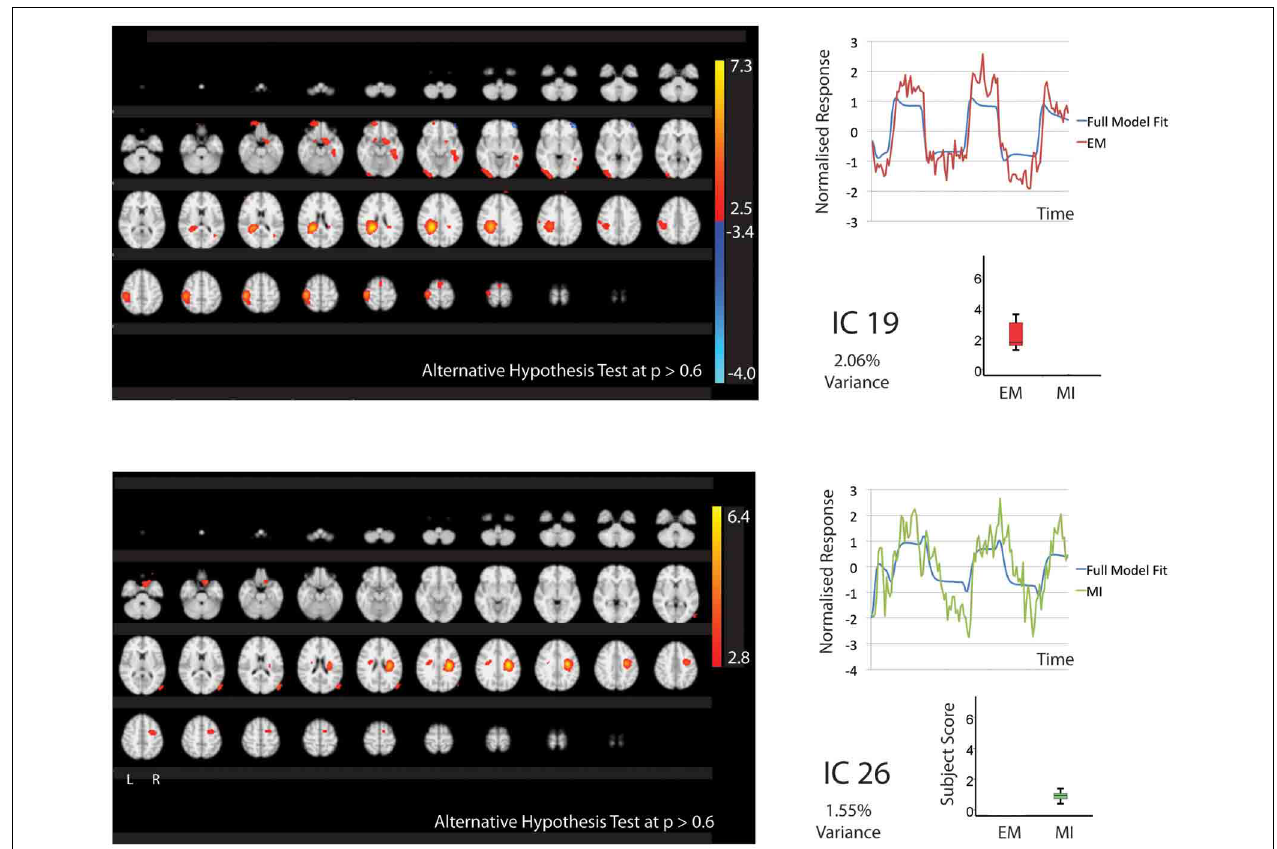
FIGURE 3 | The figures show the involvement of each IC across the whole brain with a standard threshold of p > 0 . 6 (alternative Hypothesis test) and the variance is accounts for out of the total explained variance. The scales show the transformed z -score, orange is activation, blue is deactivation.